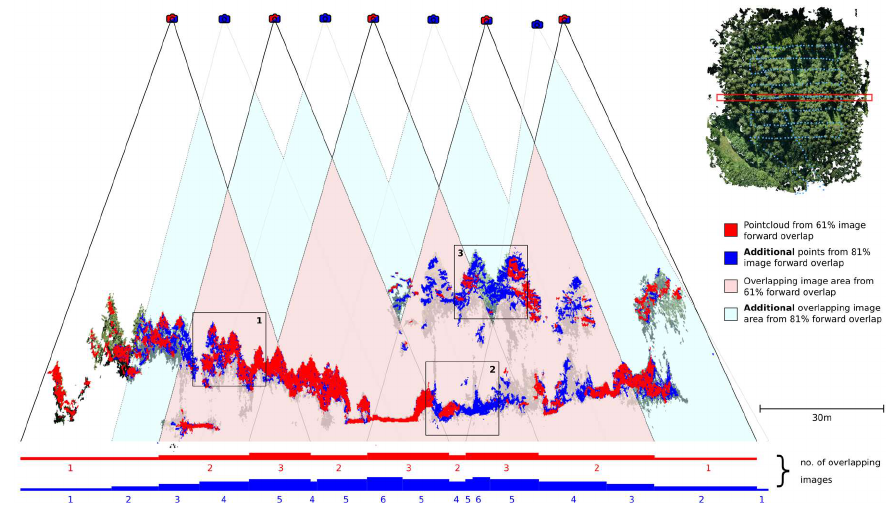
Figure 1. Illustration of reconstruction results classified by different image overlap scenarios at a 5m transect. Point colors refer to the camera icon colors used for the reconstruction. Colored background point cloud indicates best achieved result with 95% overlap. Bar charts indicate the number of overlapping images on the ground at the specific position at 61% (red) and 81% (blue) overlap. Numbered boxes highlight varying reconstruction quality across different scenes, with (1) showing low vegetation; (2) showing understory vegetation; and (3) showing upper canopy reconstruction.